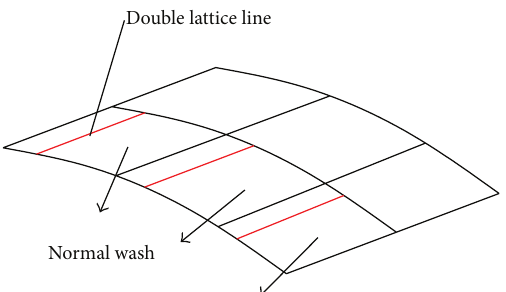
Figure 5: Typical doublet-lattice line and its normal